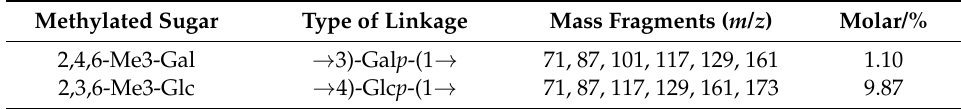
Table 4. Methylation analysis of